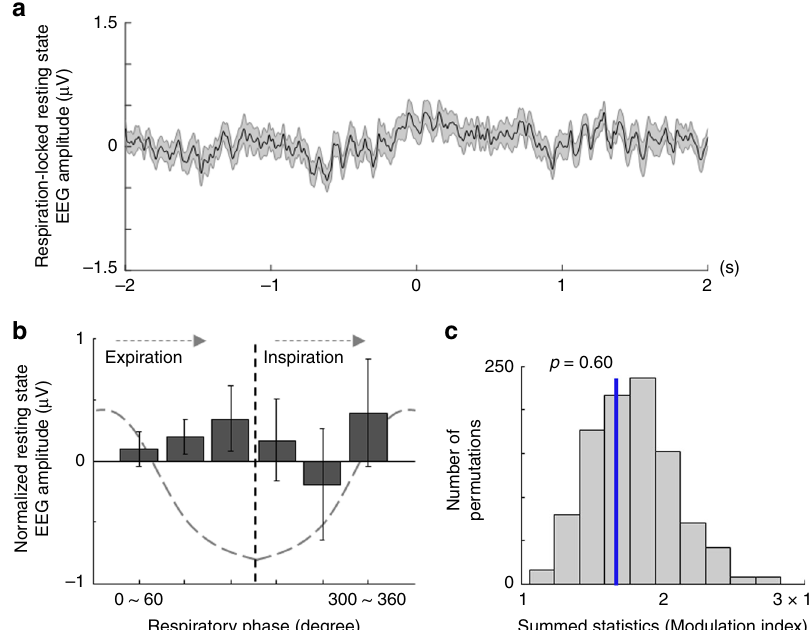
Fig. 4 Respiratory phase and resting state EEG amplitude. a Waveform of resting state EEG amplitude time-locked to the respiration (i.e., inspiration) peak obtained from fronto-central electrodes ( n = 50). Gray shaded area represents the s.e.m. b Resting state EEG amplitude as a function of six equally sized bins of respiratory phase. Error bars represent the s.e.m. c Histogram of the summed statistics (i.e., Modulation index) obtained from surrogate respiration data whose phase is randomly shifted. The blue vertical line indicates the summed statistics from original respiration data. The result suggests that respiration-locked resting state EEG amplitude does not depend on the respiratory phase (permutation p =